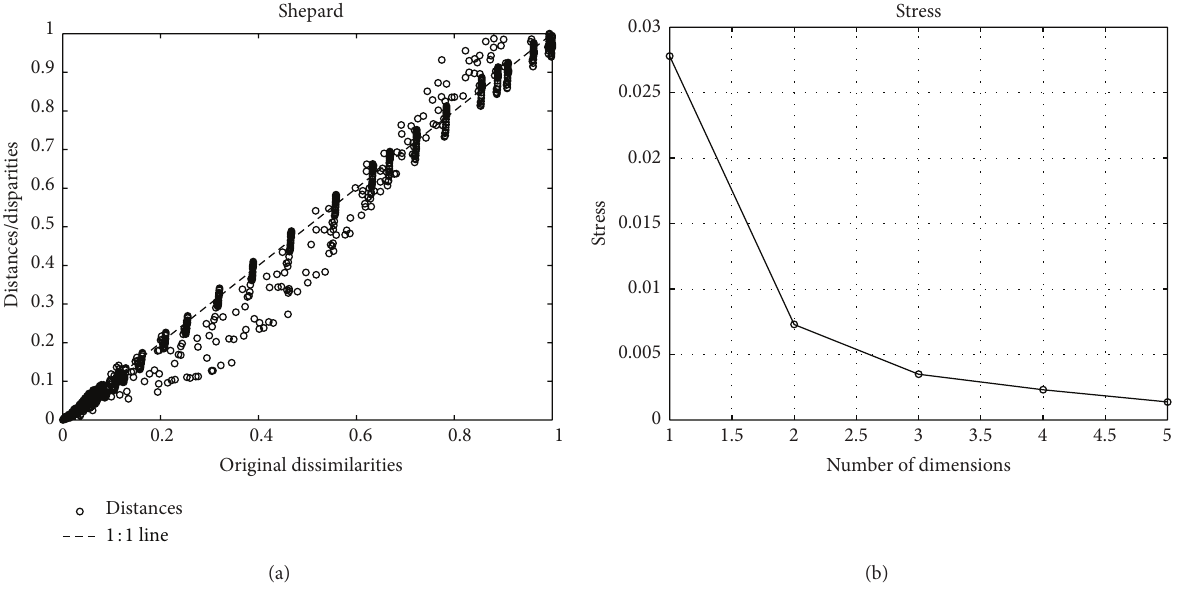
Figure 8: Shepard diagram of the two-dimensional and stress plot of the MDS representation of the Portuguese economic evolution with 𝑟 𝐸 , 𝑇 = 1865 – 2010 , and ℎ = 2 years.